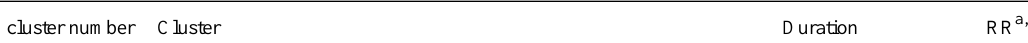
RR a,b DurationClusterRegion, date range, and cluster number